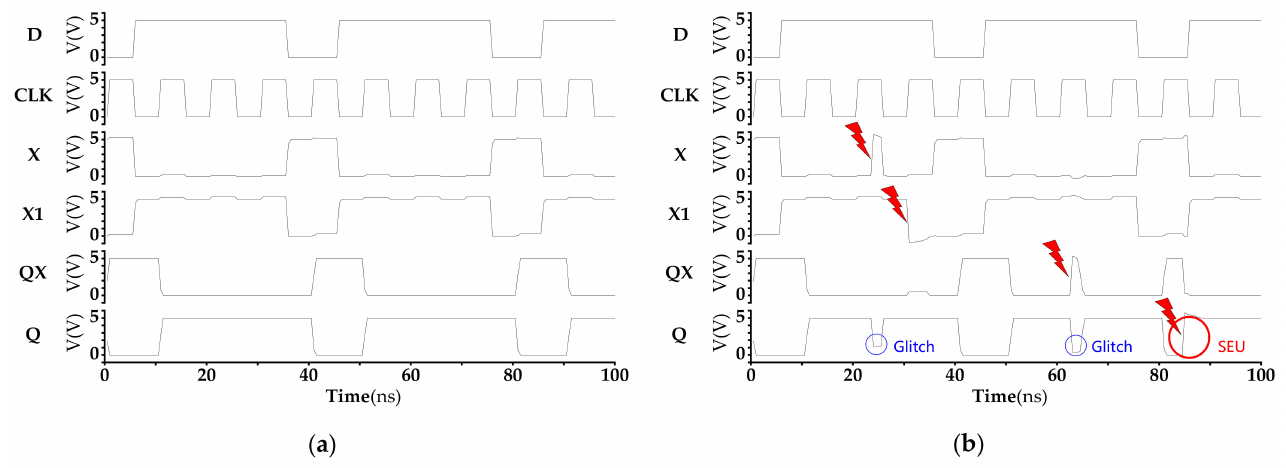
Figure 15. C 2 MOS-Quatro: ( a ) simulation waveform of C 2 MOS-Quatro without SETs; ( b ) simulation waveform of C 2 MOS-Quatro with